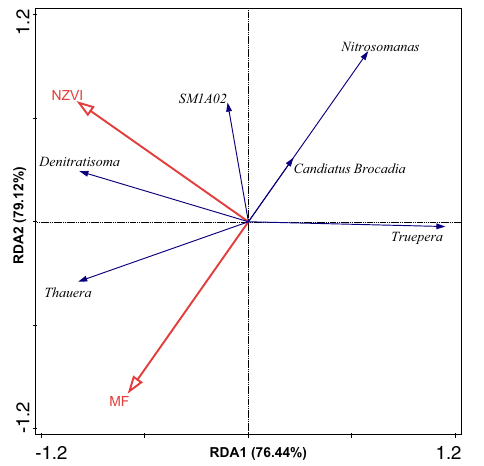
Fig. 6 The redundancy analysis (RDA) based on functional species. The RDA plot showed the correlation between the relative abundance of functional species and environmental parameters (nZVI and